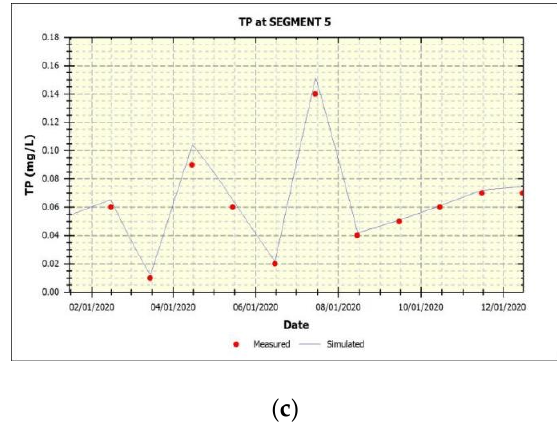
Figure 3. ( a ), ( b ) and ( c ) Comparison of the simulation results and measured data of COD, AN and TP in Segment 5 (2020). Table 12. Simulation results of concentrations in normal, dry and wet seasons (2020).